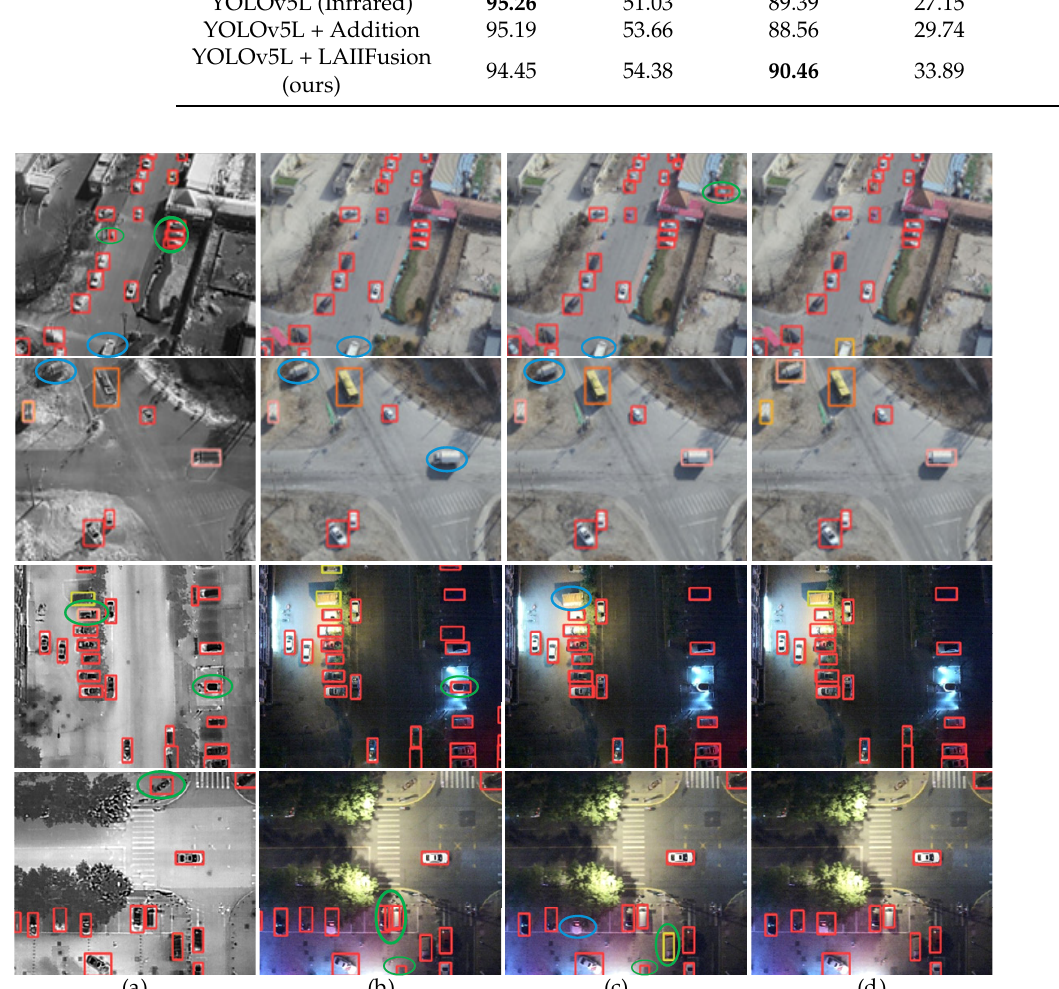
Figure 9. Visualization of only infrared images ( a ), only visible images ( b ), addition method ( c ), and proposed LAIIFusion ( d ) detection results on DroneVehicle dataset. The missed object is marked with blue circles. The incorrect object is marked with green circles. Red, yellow, pink and orange rectangles represent cars, vans, freight cars and bus targets,